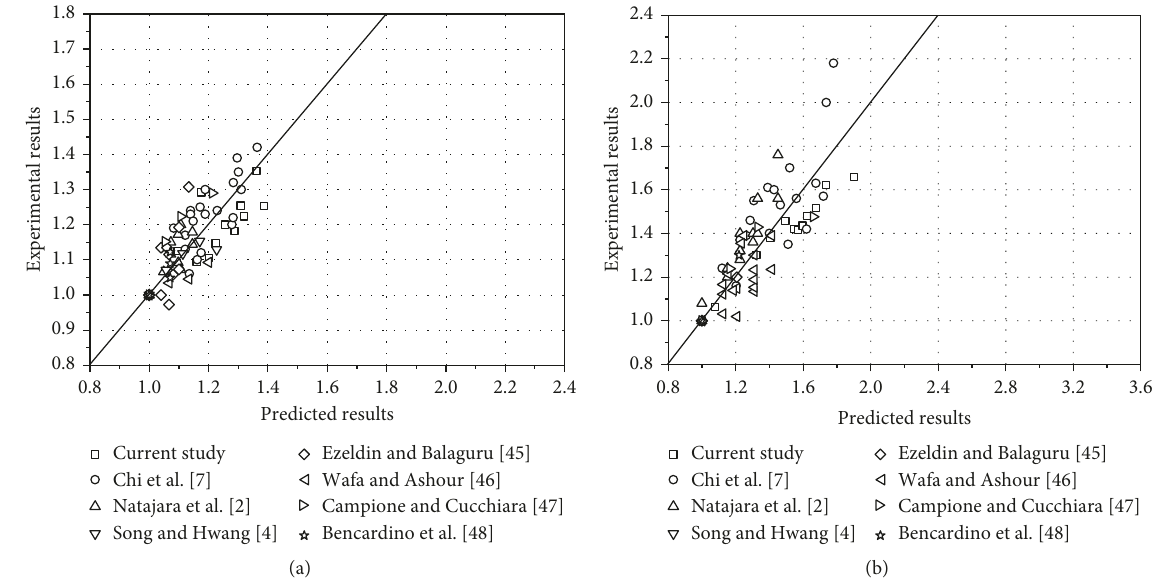
Figure 16: Variation of n with ε